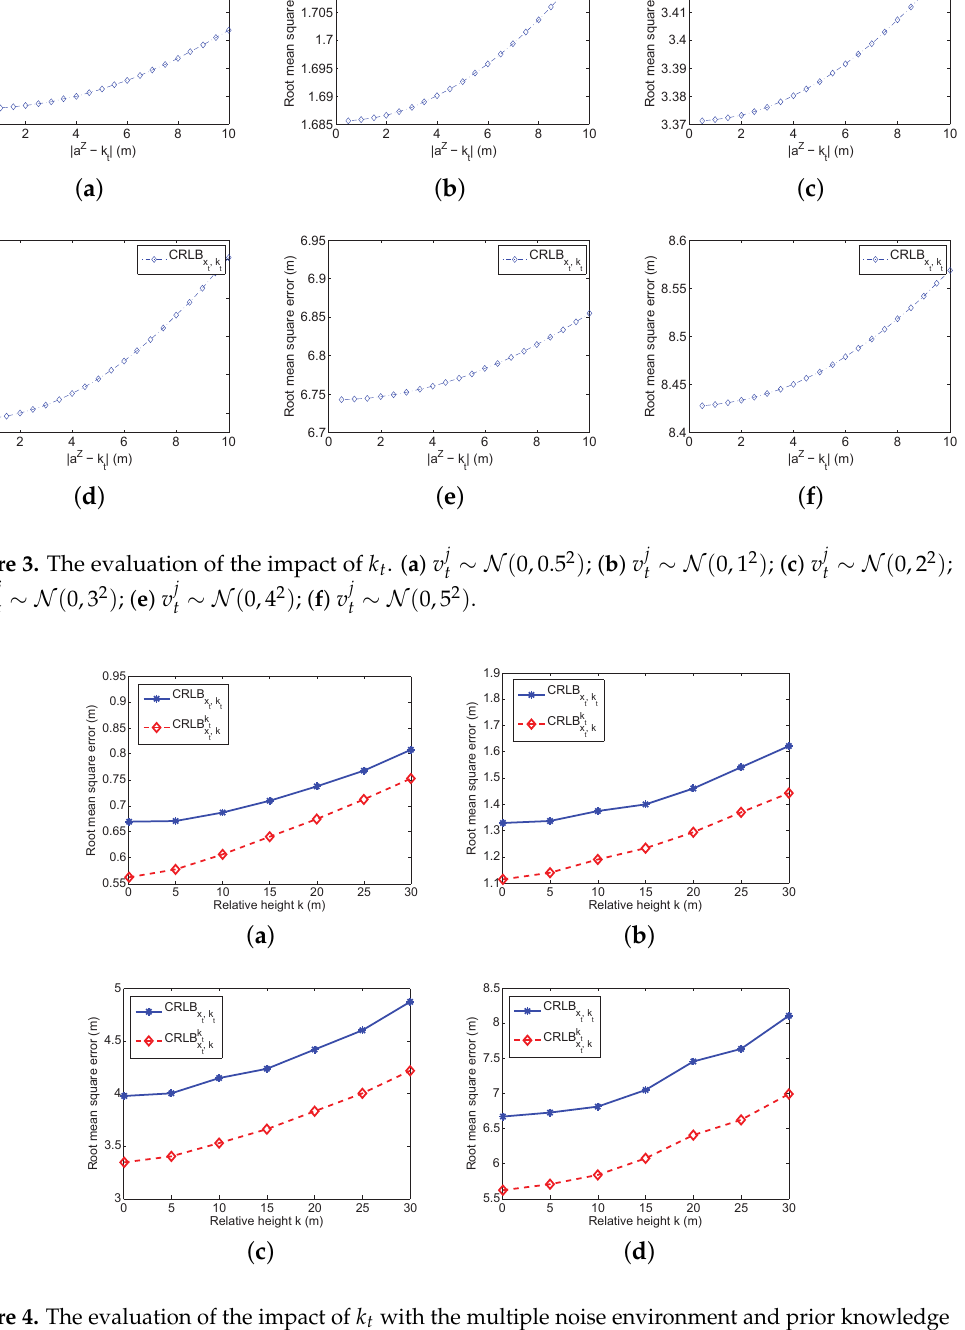
∼ N ( 0,1 2 ) ; ( c ) v j ∼ N ( 0,3 2 ) ; ( d ) v j ∼ N ( 0,5 2 ) t t t